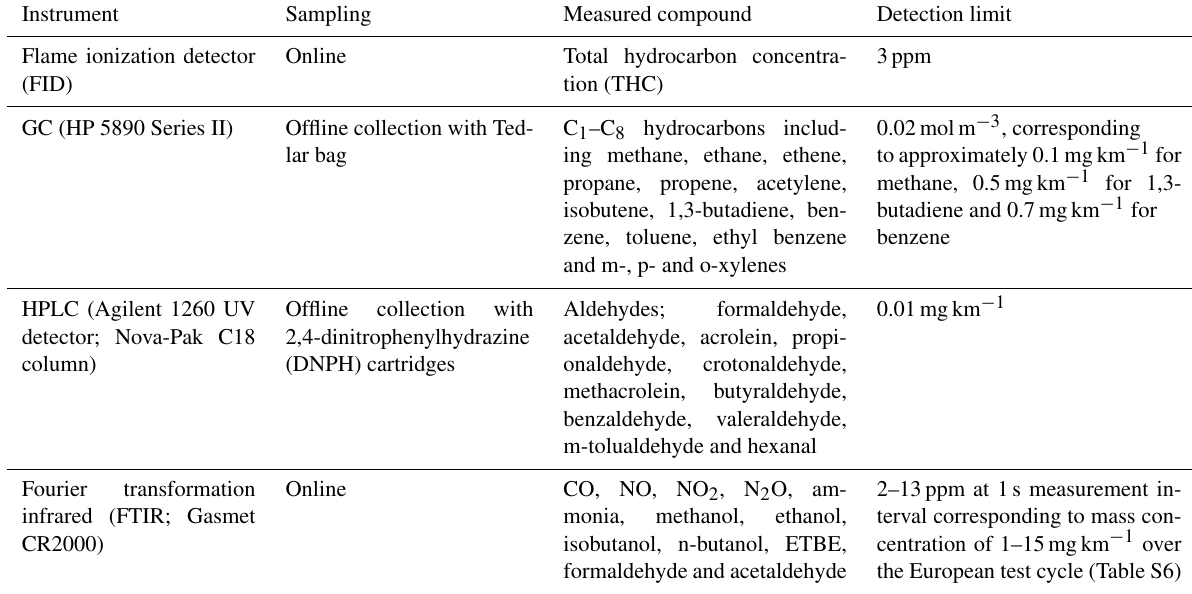
Table 2. A summary of the measured gaseous compounds, the instruments used and their detection limits.